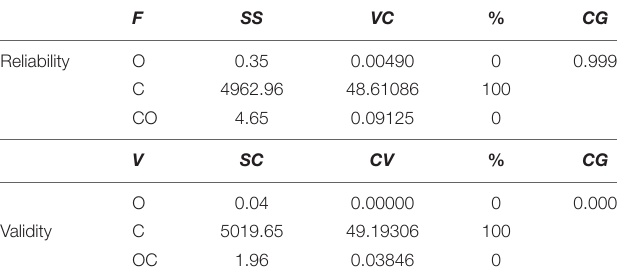
TABLE 1 | Interrater reliability and validity of the coding instrument.